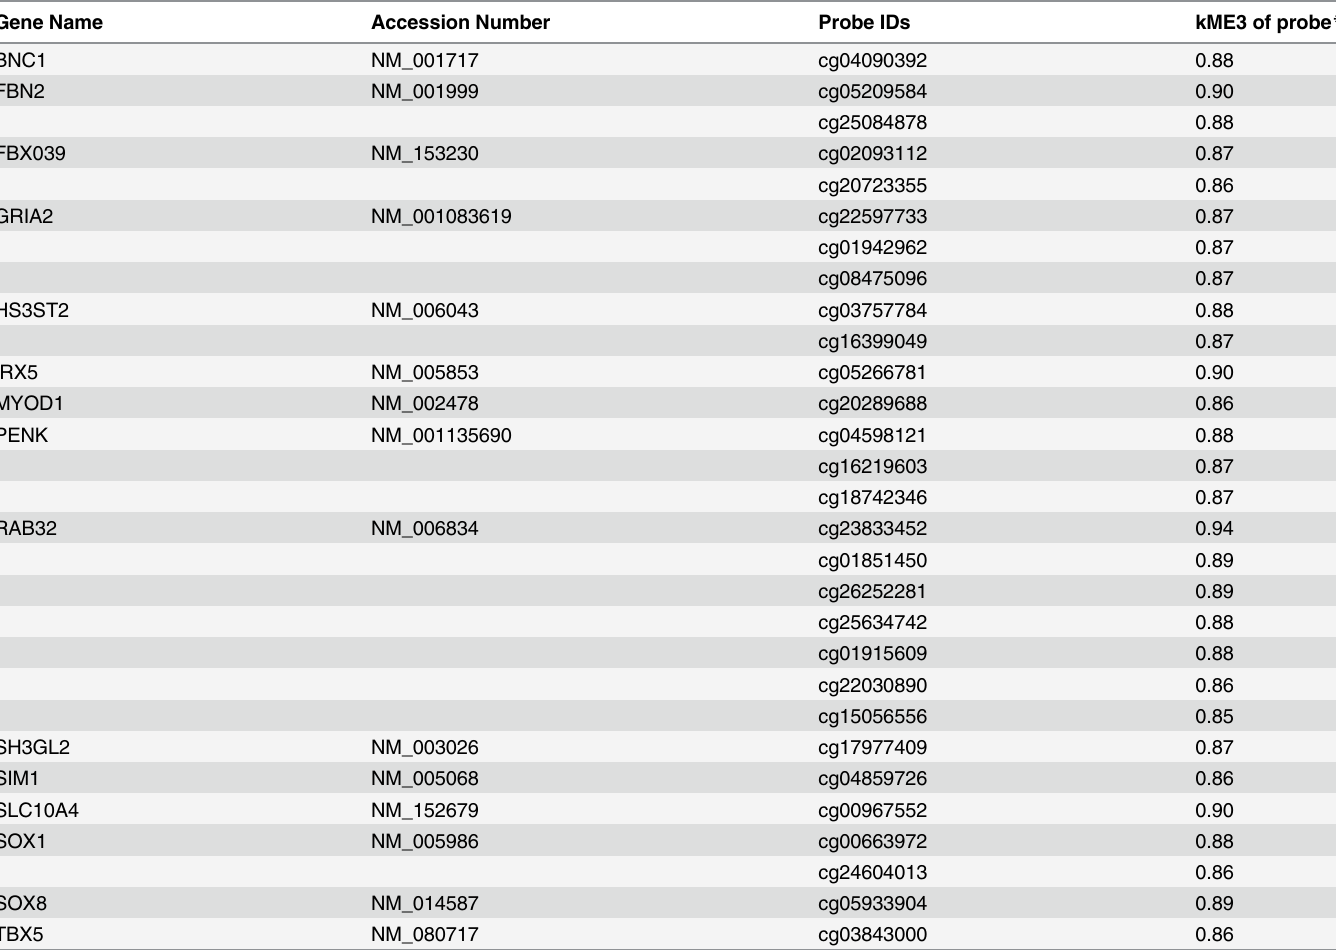
Table 4. Polycomb group target genes (PCGT) represented in module eigenvector